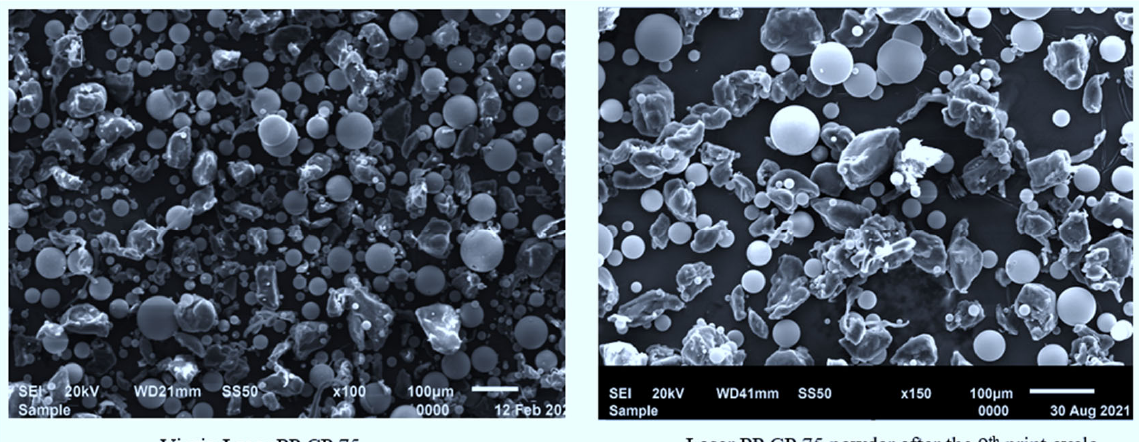
Figure 16. Powder morphology for Laser PP CP 75.